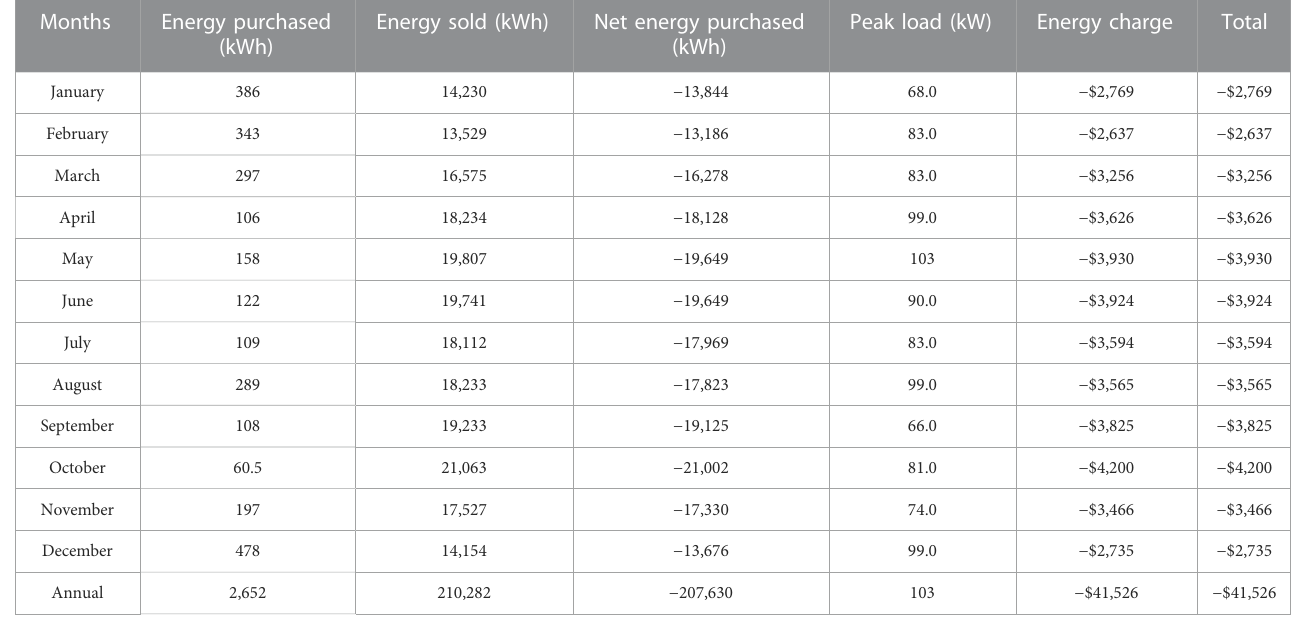
TABLE 7 Analysis of energy production for the whole year in the proposed scheme.